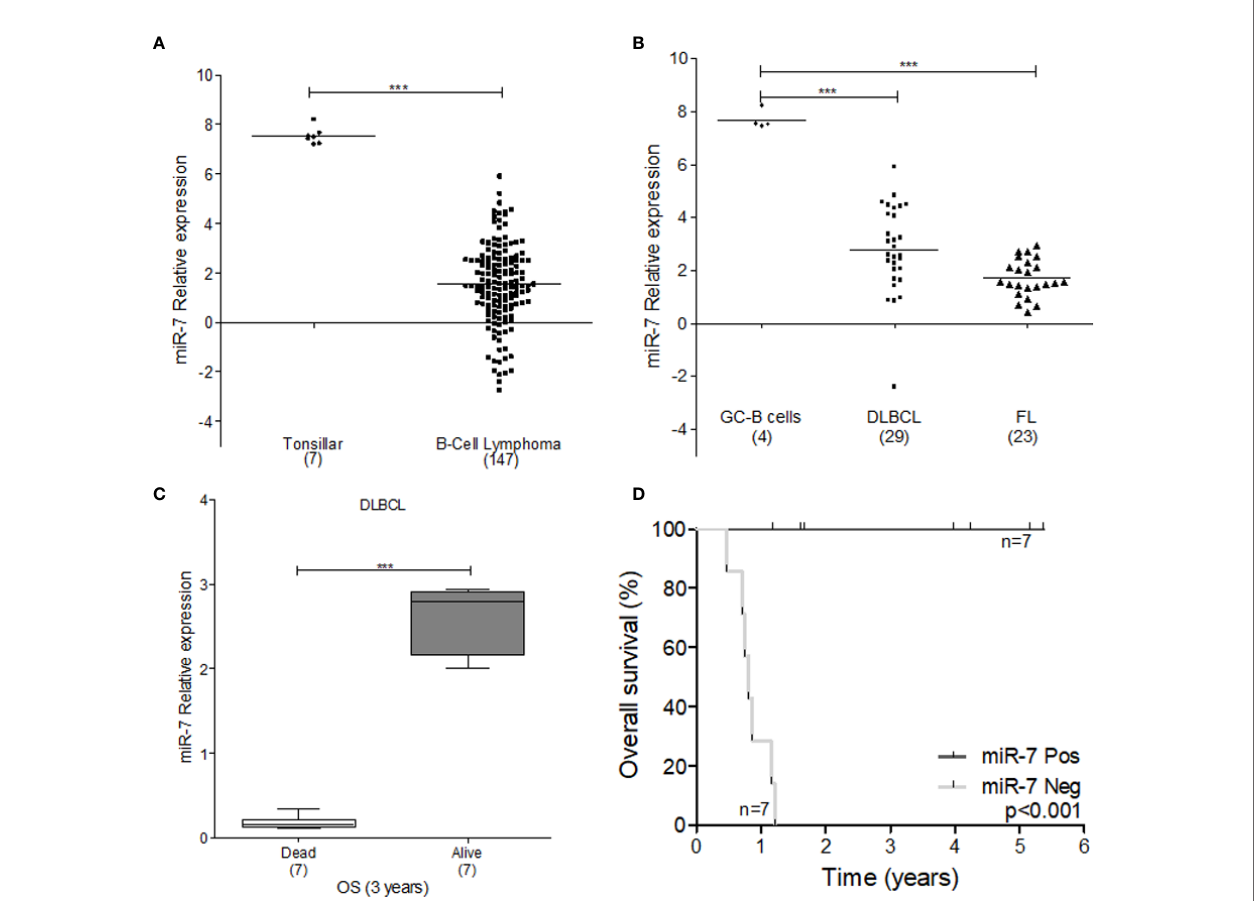
FIGURE 6 | Expression of miR-7 is downregulated in lymphoma tissues. (A) Expression of miR-7 in B-Cell lymphoma is downregulated compared to normal tonsillar tissue (***P < 0.001), (B) miR-7 expression was downregulated in DLBLC and FL compared to normal GC B-cells (***P < 0.001). Data set obtained from GEO: GSE29493 (C) miR- 7 expression is downregulated in dead patients compared to alive patients attending to overall survival at 3 years. Data set obtained from GEO: GSE31312 (***P < 0.001). (D) Overall survival of patients with diffuse large B-cell lymphoma according to miR-7 expression. The number of patients (n) is listed next to the result (***p < 0.001